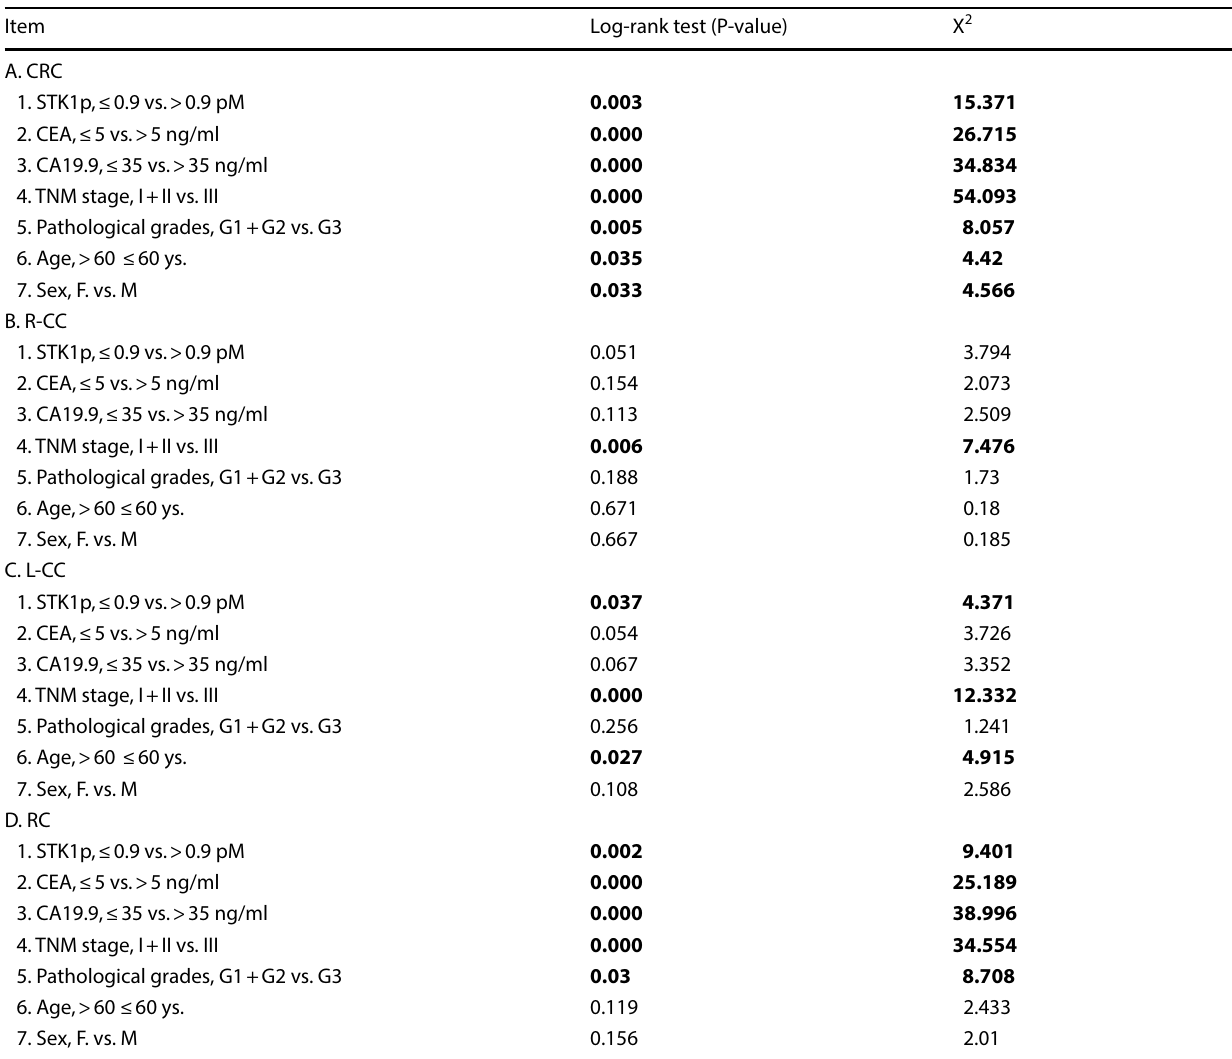
Table 2 Kaplan ‒ Meier plots evaluating the OS of CRC and its PTL as a function of seven prognostic factors (STK1p, CEA, CA19.9, TNM stage, pathological grade, age and sex)